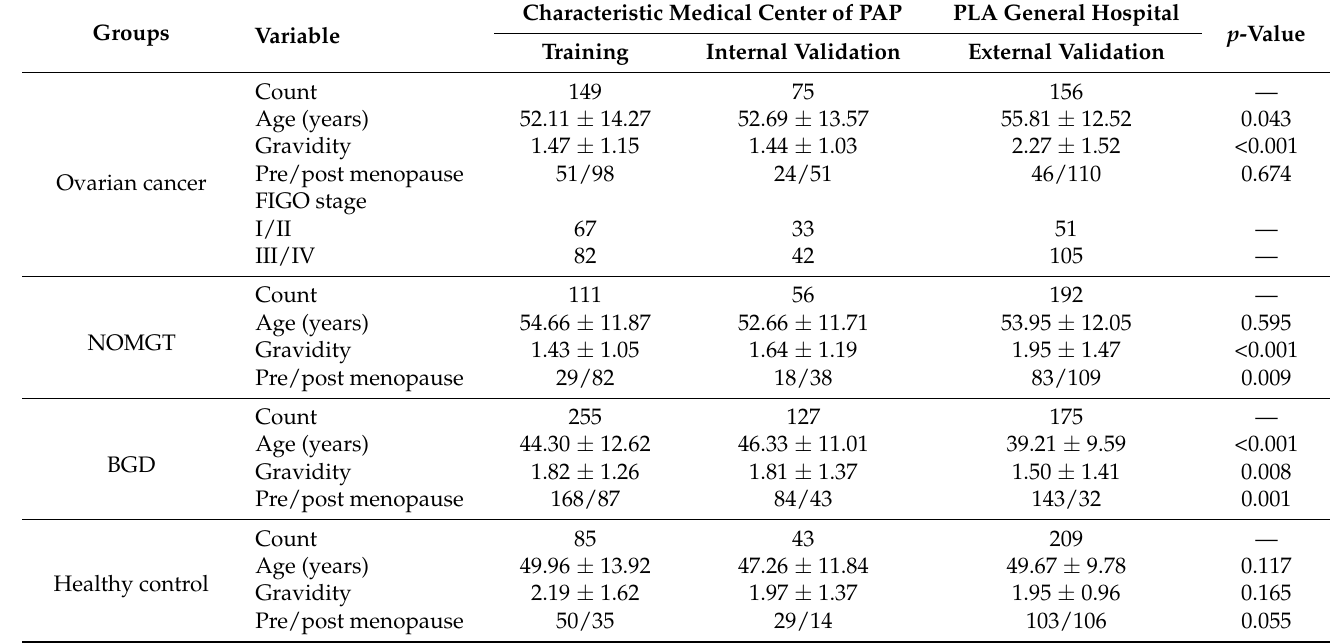
FIGO, International Federation of Gynecology and Obstetrics; NOMGT, non-ovarian malignant gynecological tumor; BGD, benign gynecological